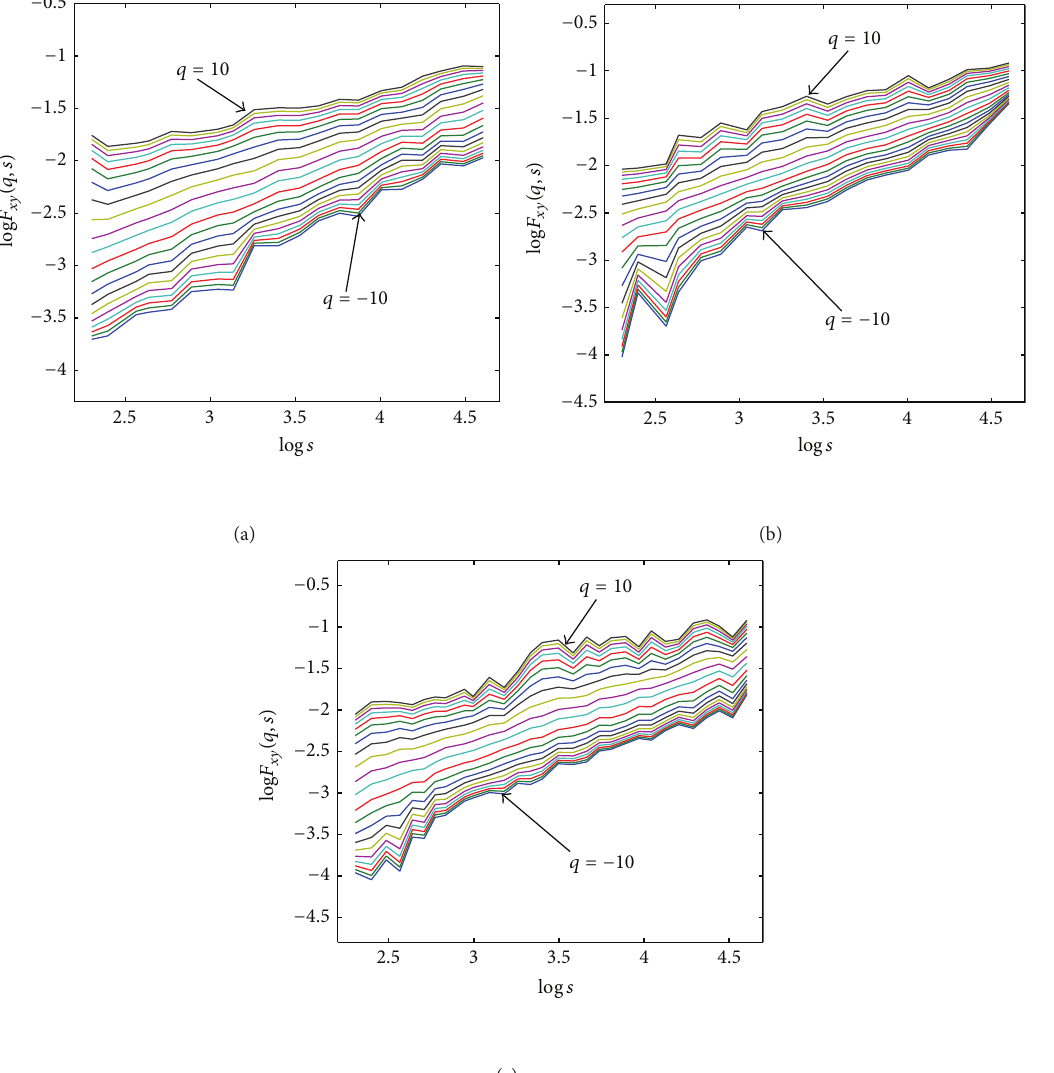
Figure 4: Log-log plots of 𝐹 𝑥𝑦 (𝑞,𝑠) versus 𝑠 for (a) the real markets and (b), (c) the proposed model with S.data1 and S.data2, respectively.